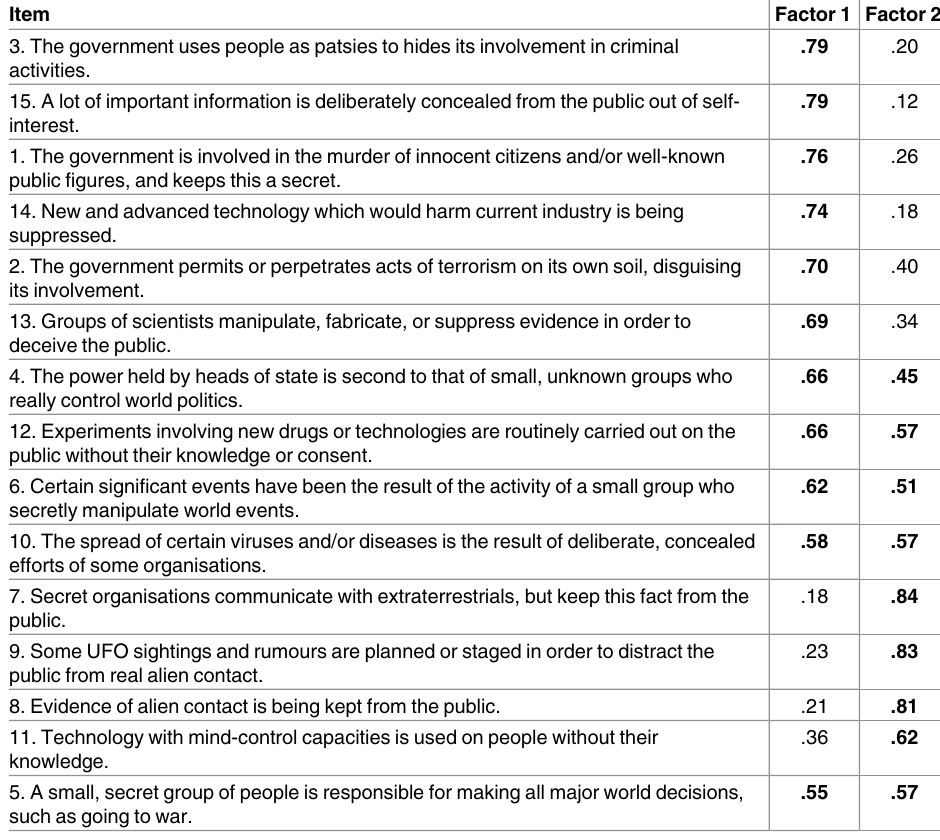
Table 6. Items and factor loadings for the Generic Conspiracist Beliefs Scale. Values in bold indicate items that loadedonto a factor. Item Factor 1 Factor